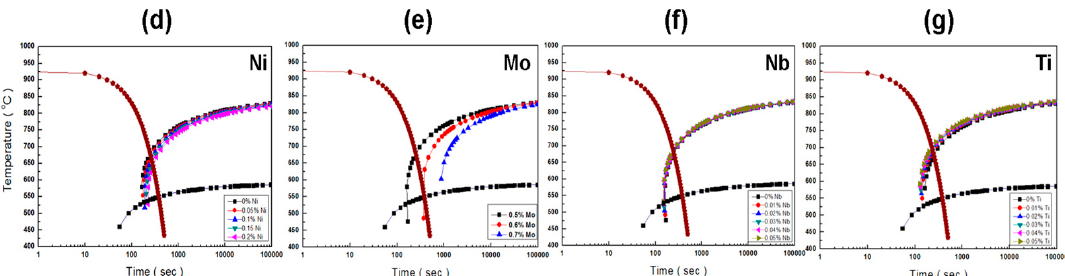
Figure 4. The effects of elemental additions on the ferrite continuous cooling transformation (CCT)